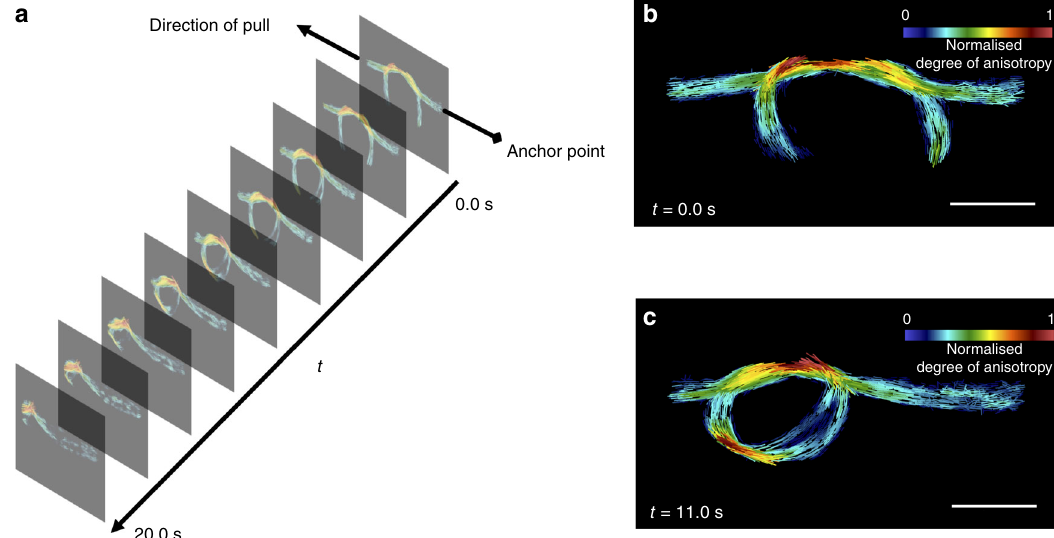
Fig. 4 Real-time omnidirectional scattering imaging. a Schematic of the experimental setup with an ensemble of images encoding the underling fi bre orientation and the degree of anisotropy. The fi bre knot was pulled from one end while being anchored from the other. The images were collected with a frame rate of 25 frames per second for a total duration of 20 s. Extracted images at two different time points ( b ) t ¼ 0 : 0 s and ( c ) t = 11.0 s. The scale bars correspond to 4